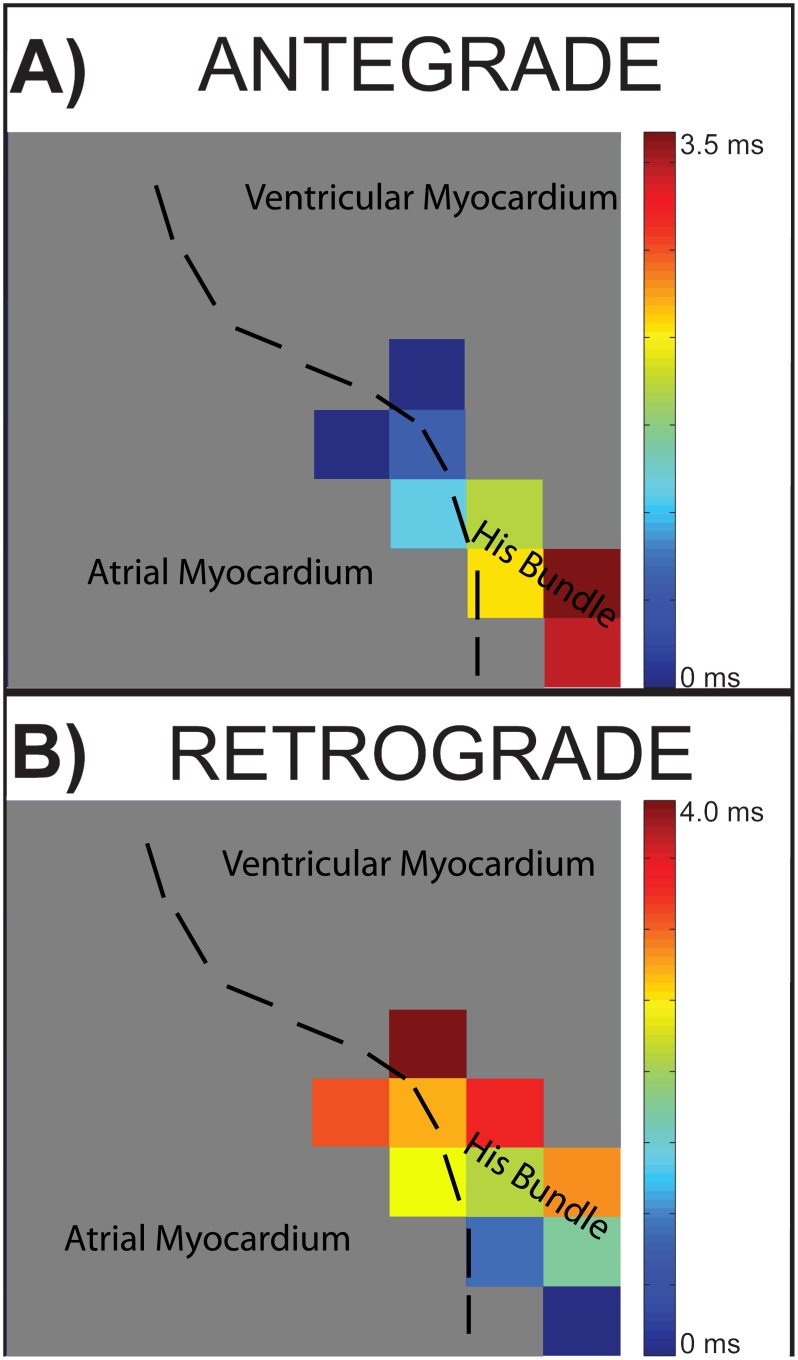
Example of His bundle antegrade and retrograde conduction.The plaque shown is a 8×8 array with 300 um electrode spacing, which covers a 2.1 mm x 2.1 mm region of the endocardium. Regions not containing strong His activity are shown in gray. A) Conduction during sinus rhythm was in the antegrade direction. B) Conduction in the His bundle during VF was almost always in the retrograde direction. The example shown is during perfused VF.